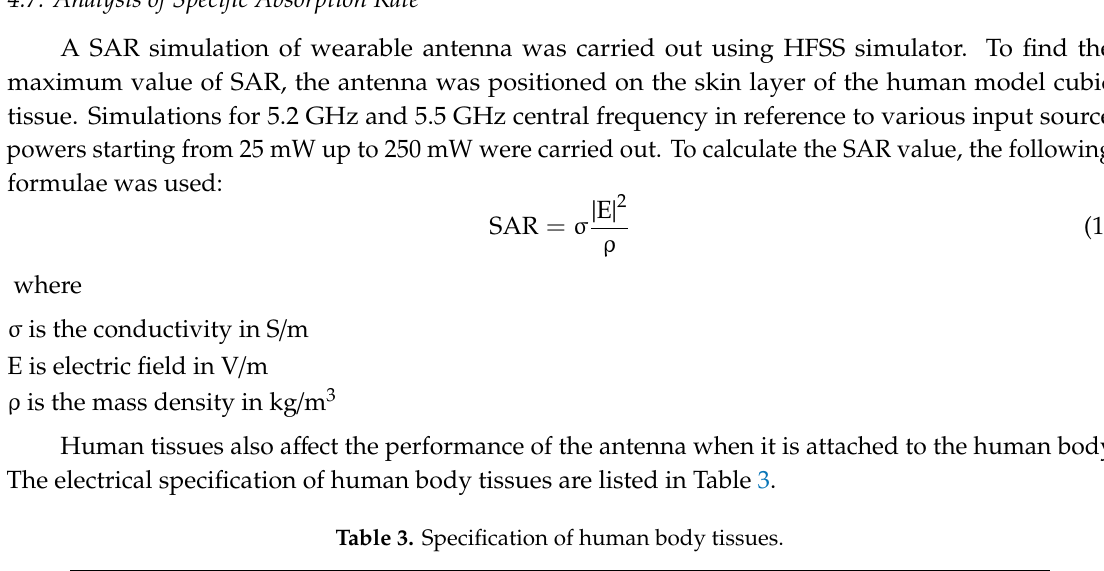
Figure 13. Simulated surface current distribution at 12.2 GHz.